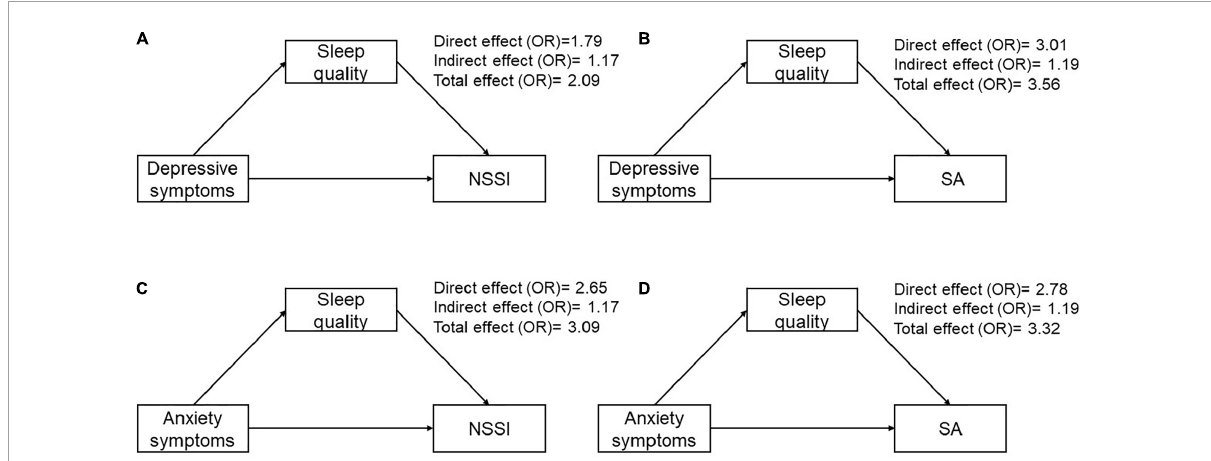
FIGURE2 The odds ratio of proposed theoretical model. (A) Direct and indirect effects mediated through sleep quality of depressive symptoms on NSSI. (B) Direct and indirect effects mediated through sleep quality of depressive symptoms on SA. (C) Direct and indirect effects mediated through sleep quality of anxiety symptoms on NSSI. (D) Direct and indirect effects mediated through sleep quality of anxiety symptoms on